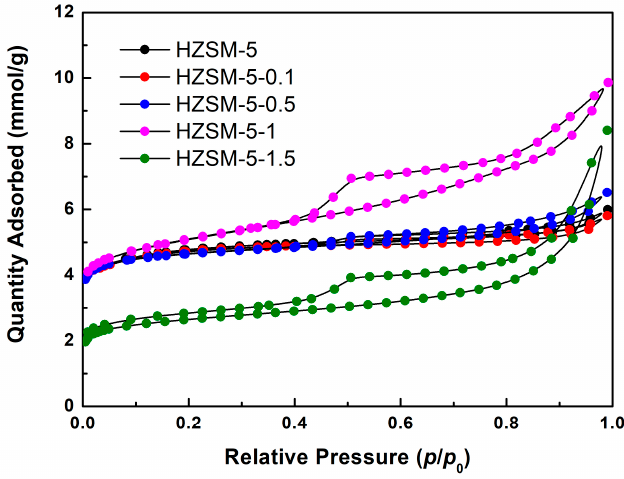
Figure 1. N 2 physisorption (at 77 K) isotherms for parent HZSM-5 and the hierarchical HZSM-5 treated with different concentrations of NaOH solution (0.1–1.5 M) at 343 K for 1 h. Table 1. Physicochemical properties of parent HZSM ‐ 5 and the hierarchical HZSM ‐ 5 treated with different concentrations of NaOH solution (0.1–1.5 M) at 343 K for 1 h. Sample